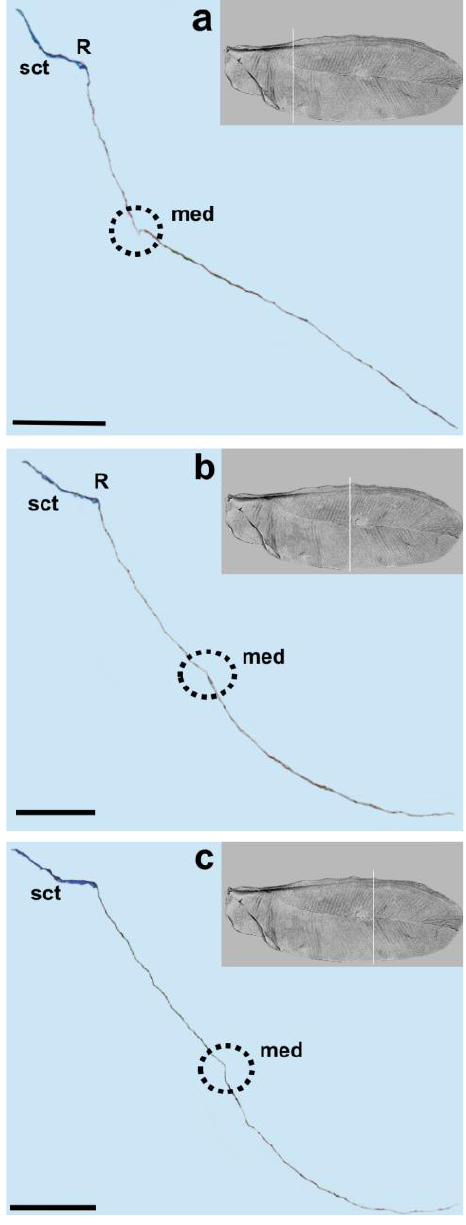
Figure 5. Cross-section of the wing of M. pini . Scale bar 100 µ m; ( a – c ) median fold in black dotted circle.